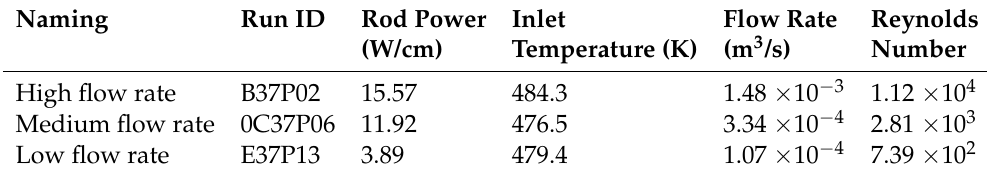
Table 6. Validation cases selected in Toshiba’s 37-pin benchmark.